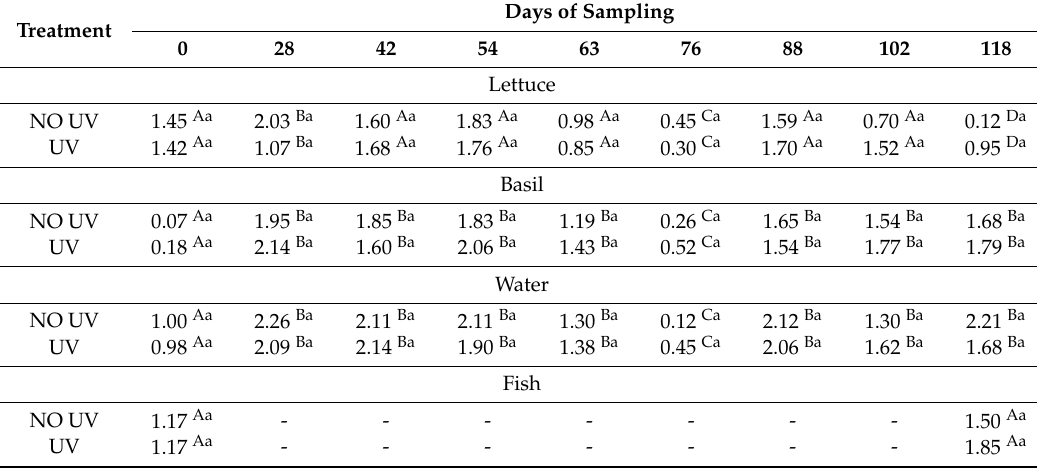
Table 3. Log 10 of coliform counts collected from basil, water, lettuce, and fish over 118 days in an aquaponic model